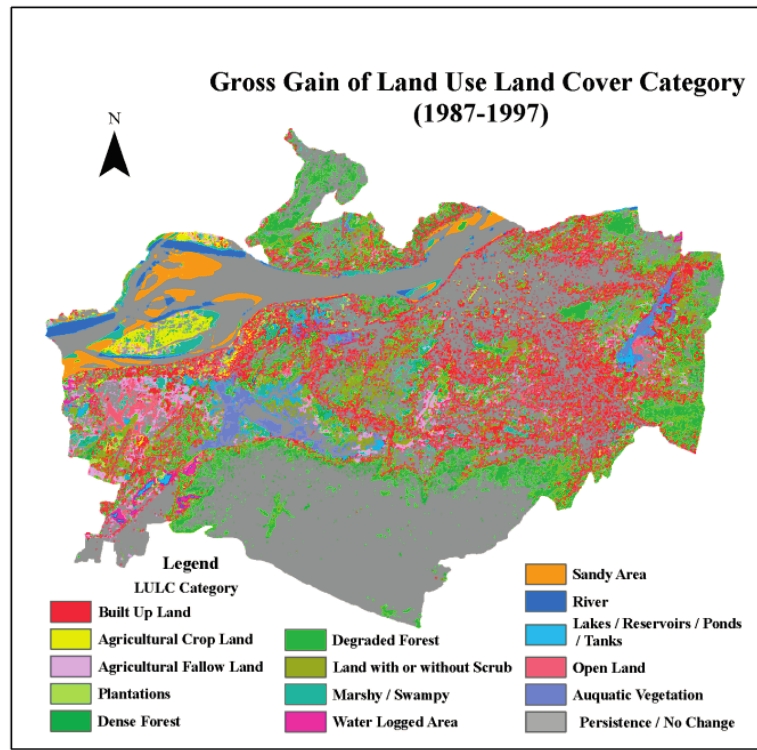
Figure 13. Gross gain of each LULC category during 1987 and 1997.